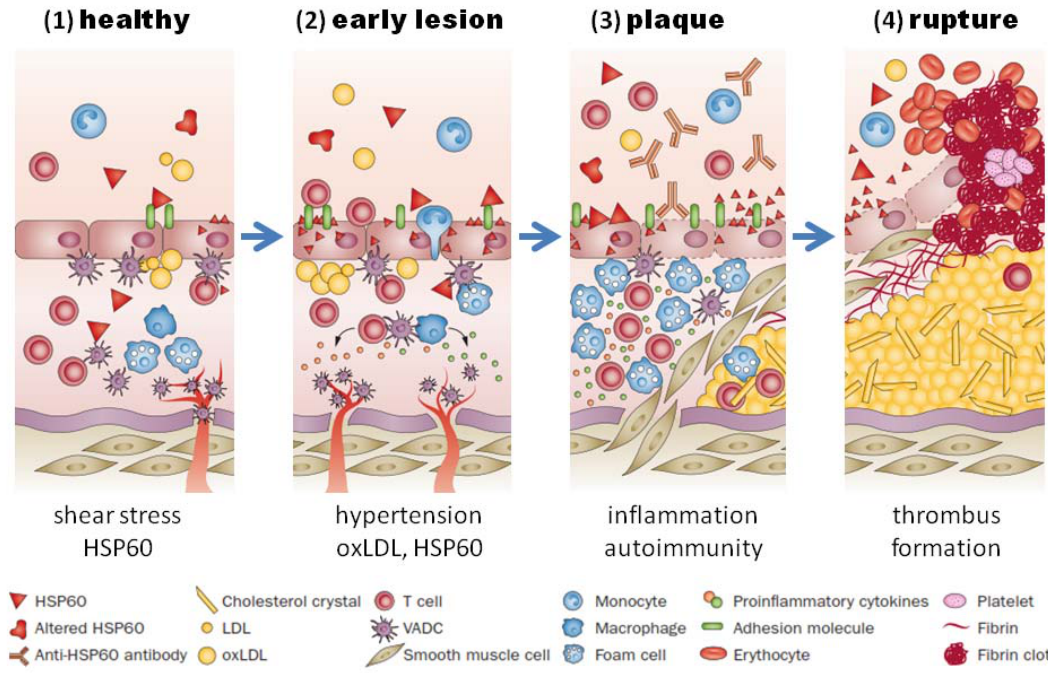
Figure 2. HSP60 ‐ induced atherosclerosis. ( 1 ) Healthy arteries are exposed to hemodynamic turbulences leading to shear stress at curves and branching points, which are prone to atherosclerosis; ( 2 ) classic risk factors (i.e., high blood pressure) may aggravate the stress response in endothelial cells, which leads to more surface expression of adhesion molecules and HSP60. This, together with secreted HSP60, attracts T cells and other proinflammatory cells to infiltrate the intima. Binding of cross ‐ reactive antibodies to HSP60 to endothelial cells induce an autoimmune response, which promotes endothelial dysfunction and migration of mononuclear cells into the intima; ( 3 ) plaques start to develop, when macrophages and vascular smooth muscle are transformed to foam cells and produce proinflammatory cytokines. Soluble HSP60 is further released from damaged cells. If the inflammation persists, the lesion becomes more complex and a necrotic core composed of necrotic and apoptotic cells is formed. Cell debris, cholesterol crystals accumulate, and a fibrous cap is formed; ( 4 ) unstable plaques can rupture which leads to exposure of the core to the blood followed by thrombus formation. Abbreviations: HSP, heat shock protein; oxLDL, oxidized LDL; SMC, smooth ‐ muscle cell; VADC, vascular ‐ associated dendritic cell. Adapted from Servier Medical Art. creative